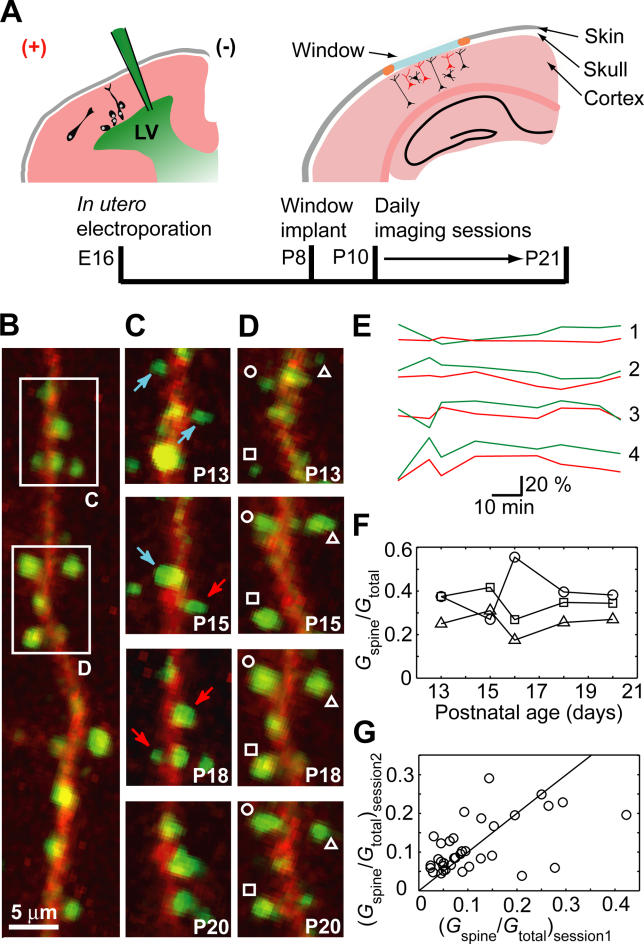
A Subpopulation of PSD-95 Clusters Is Stable over Several Days(A) Transfection of L2/3 pyramidal neurons by in utero electroporation. At E16, DNA was injected into the lateral ventricle (LV) and an electrical current was applied. At P8, imaging windows were implanted above the barrel field. High-resolution chronic imaging was performed from P10 to P21.(B) Dendritic segment transfected with PSD-95-GFP (green) and mCherry (red).(C) Time-lapse images showing turnover of PSD-95 clusters (box C, from [B]). Red arrows indicate gains; blue arrows indicate losses.(D) Time-lapse images showing stable PSD-95 clusters (box D, from [B]).(E) Fractional changes in PSD-95-GFP (green) and mCherry (red) fluorescence from four representative spines. Lines were offset for clarity.(F) Relative brightness of three PSDs (from [D]) over days. (Gtotal = fluorescence summed over all spines).(G) Brightness of individual PSDs is correlated across two imaging sessions 1 d apart (n = 3 animals, 51 spines).